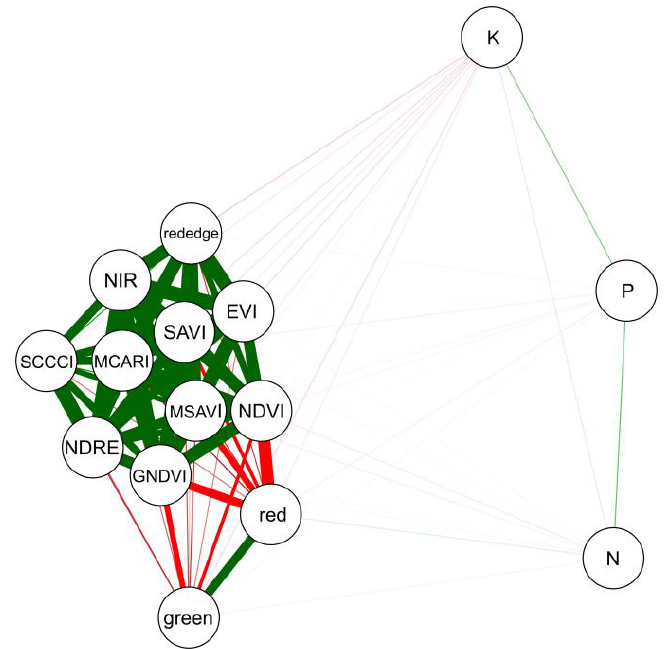
Figure 3. Pearson’s correlation network between the nutritional (potassium–K, phosphorus–P, and nitrogen–N content) and spectral variables (spectral bands and vegetation index). Variables con- nected by green lines are positively correlated, while variables connected by red lines are negatively correlated. The thickness of the line is proportional to the magnitude of the correlation.